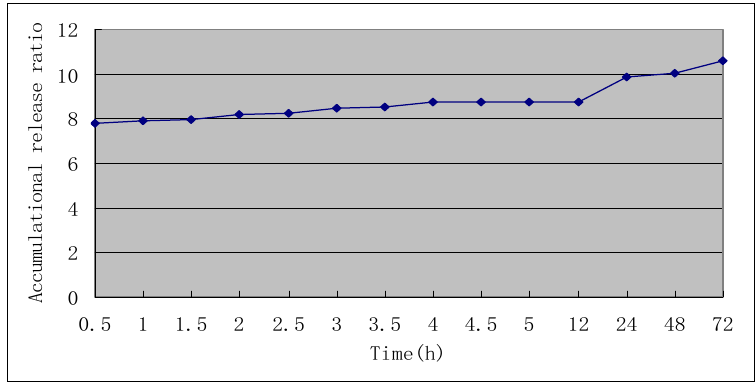
O /Mn Zn Fe O 2 3 0.5 0.5 2 4